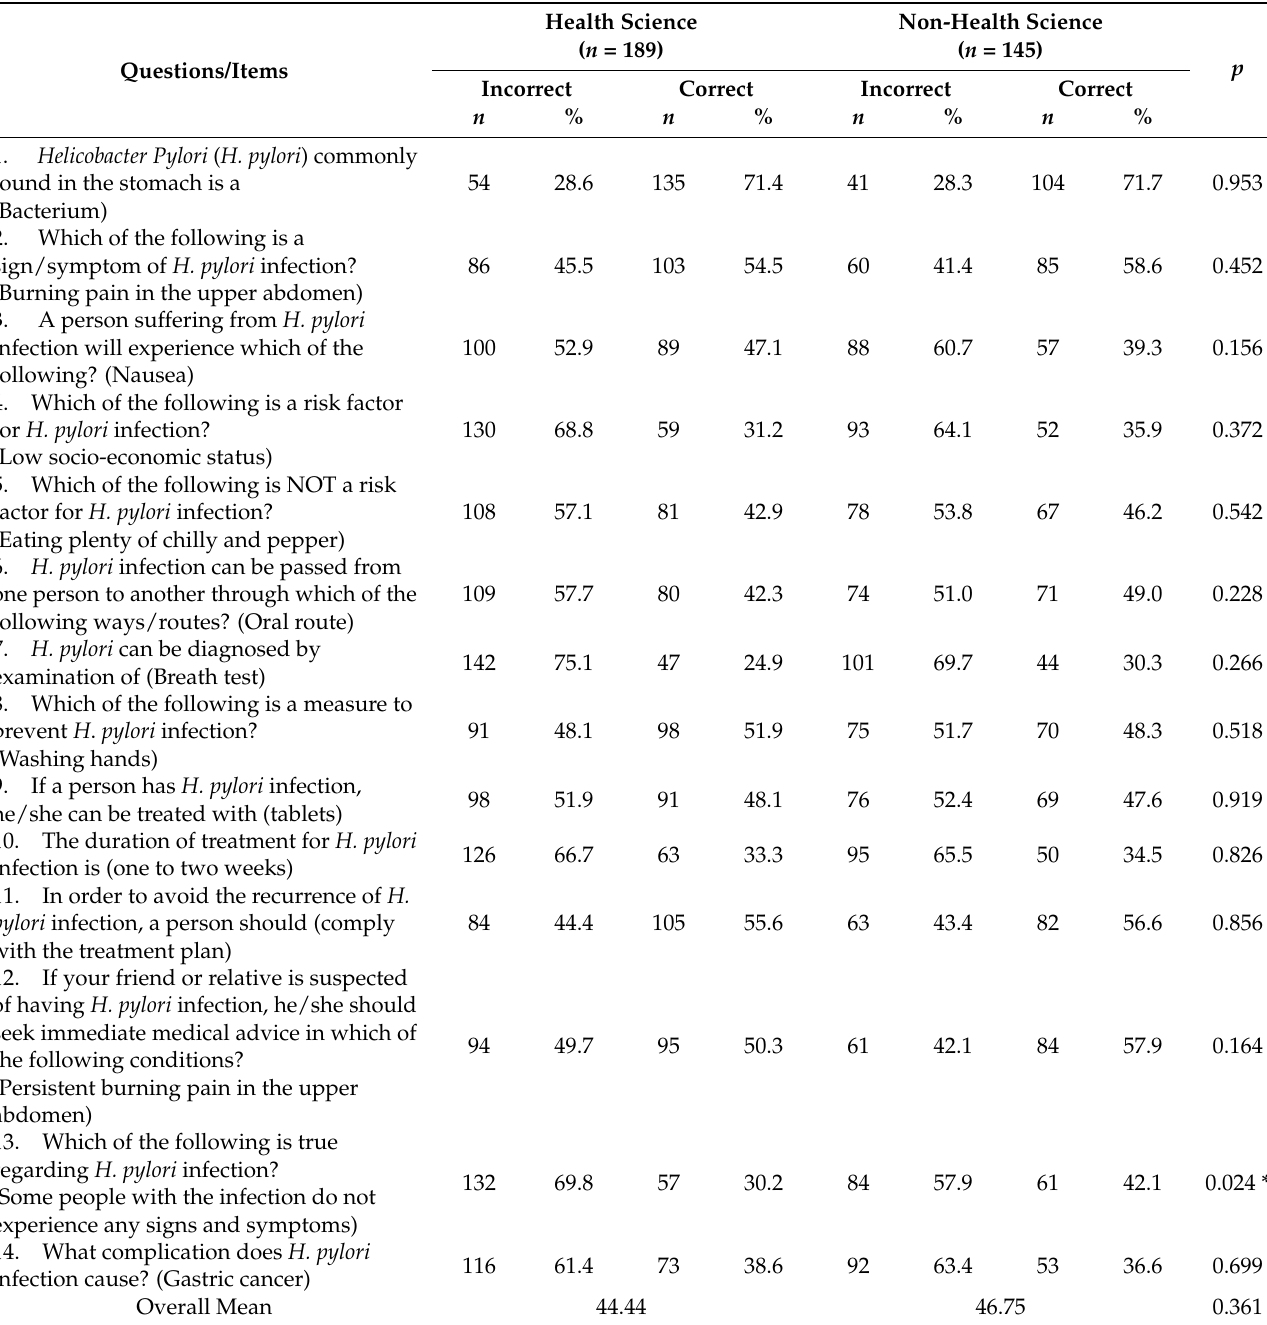
Table 2. Knowledge of the respondents about H. pylori infection items ( n =